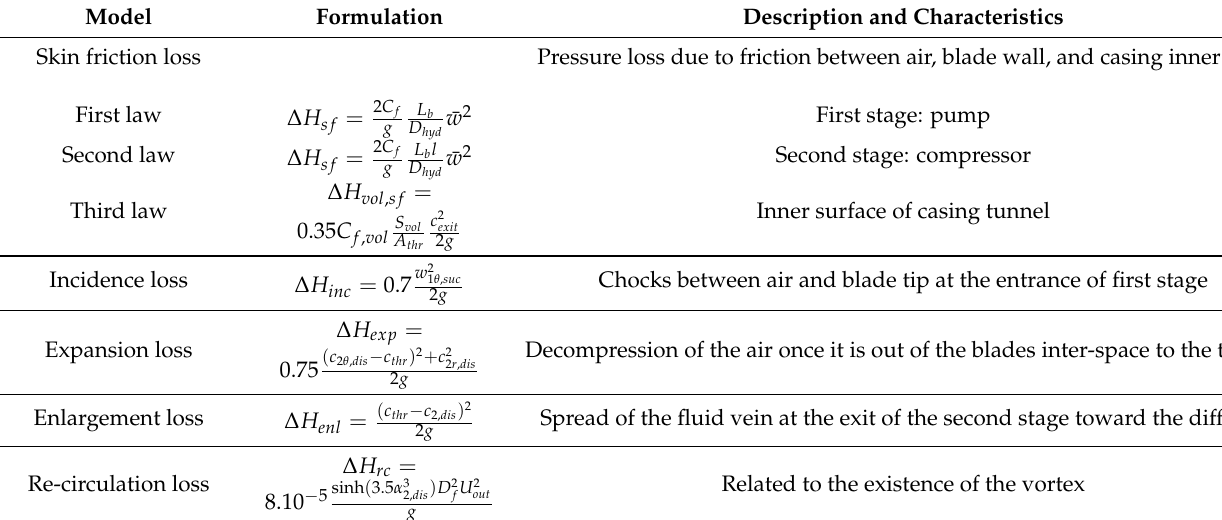
Table 1. Description of the loss models using streamline